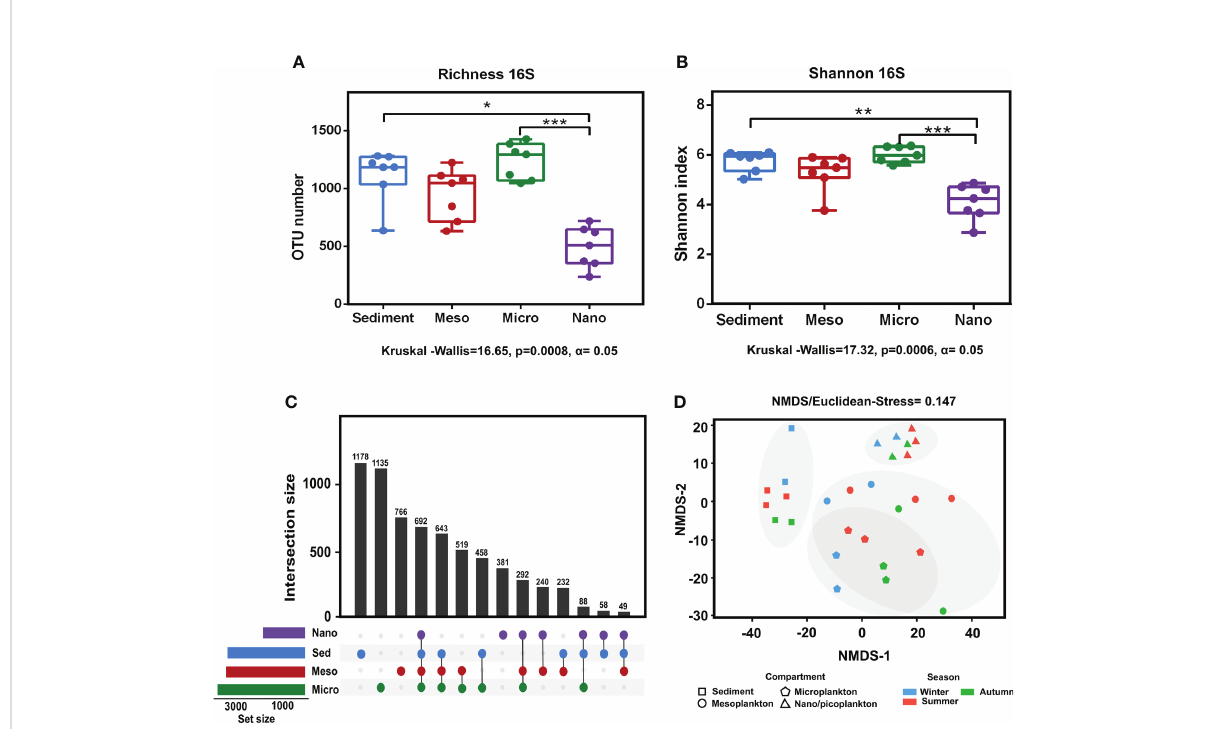
FIGURE 4 Alpha and beta diversity obtained from prokaryote sequencing. (A) Richness and (B) Shannon index obtained from each environmental compartment. (C) Exclusive and common OTUs of eukaryotes obtained from each environment. (D) NMDS based on Euclidean distances from each environmental compartment. The stress value indicated a reliable level of ordination. P-value < 0.05 (*); P-value < 0.01 (**); P-value < 0.001